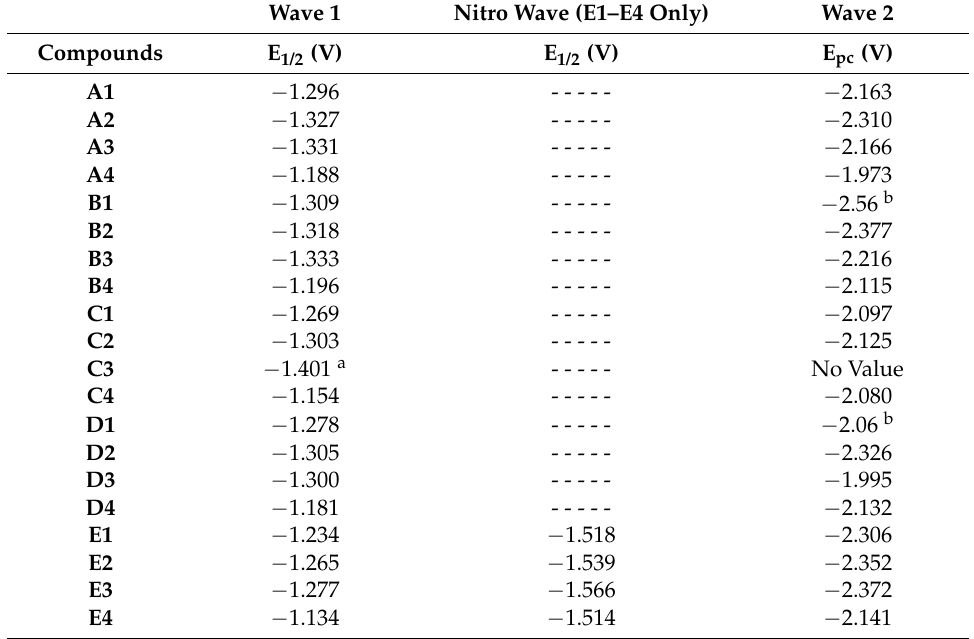
Table 5. Cyclic voltammetric data of the 3-aryl-quinoxaline-2-carbonitrile 1,4-di-N-oxide derivatives [27]. Substrate, 1.0 mM; TBAP, 0.1 M; DMF; Pt working electrode; Ag/AgNO 3 reference electrode; Pt wire electrode; 100 mV/s; room temperature; E vs. ( Fc / Fc + )/V; currents reported in µ A; voltammograms recorded with a CH Instruments Model 620 Electrochemistry Analyzer. Wave 1 Nitro Wave (E1–E4 Only) Wave 2